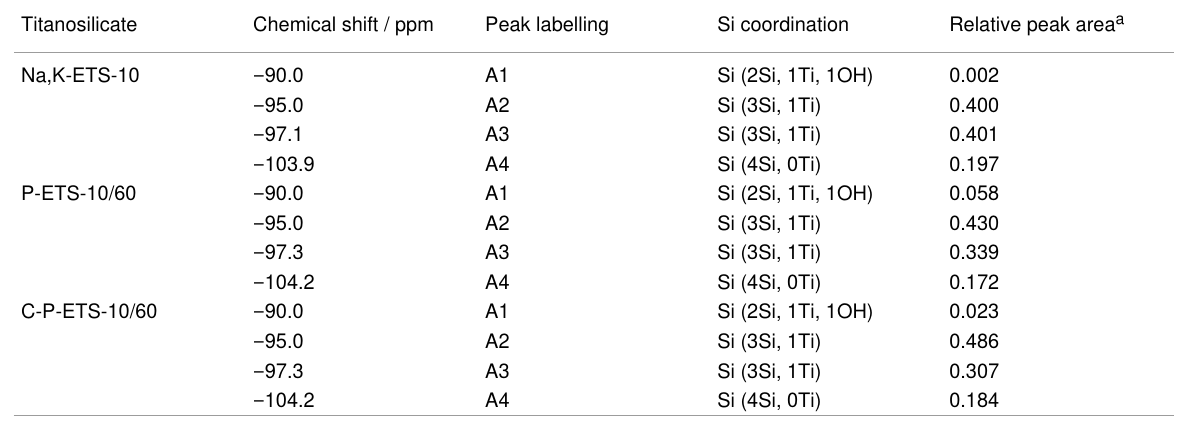
Table 3: Assignment and estimated relative peak areas of the 29 Si MAS NMR peaks presented in Figure 13A. Titanosilicate Chemical shift / ppm Peak labelling